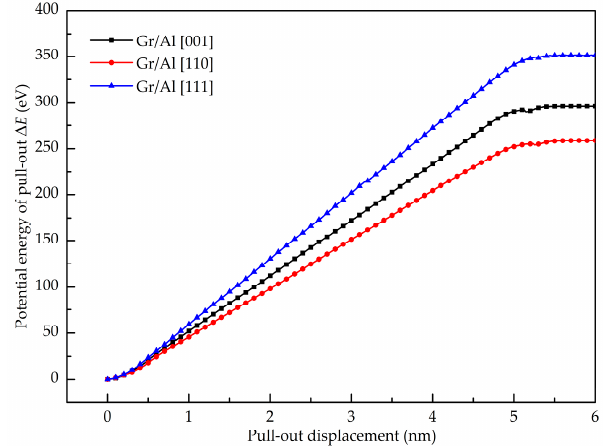
Figure 8. Potential energy increment of the different Al crystal orientations during pull-out test.